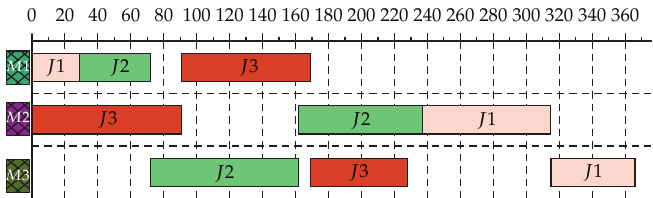
Figure 5: The Gantt chart for the new schedule generated by random perturbation.